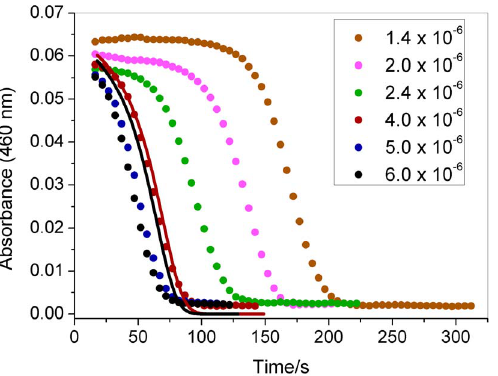
Figure 2. Effect of the ozone concentration on the clock time. The initial concentrations after mixing the reactants in the cuvette were as follows: [O 3 ] as indicated in the figure (mol L 2 1 ), [NaClO 3 ]=0.0251 mol L 2 1 , [HClO 4 ]=0.474 mol L 2 1 , and [I 2 ]=8.8 6 10 2 5 mol L 2 1 . Exper- imental data (symbols); modeling results (continuous line).